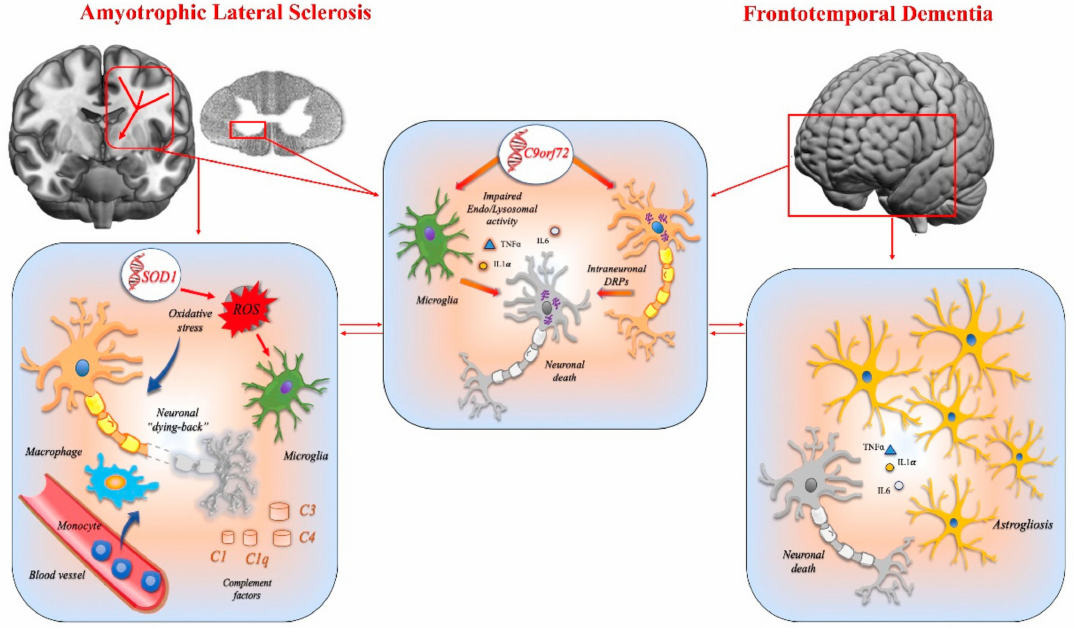
Figure 5. The immunological mechanisms associated with amyotrophic lateral sclerosis and frontotemporal